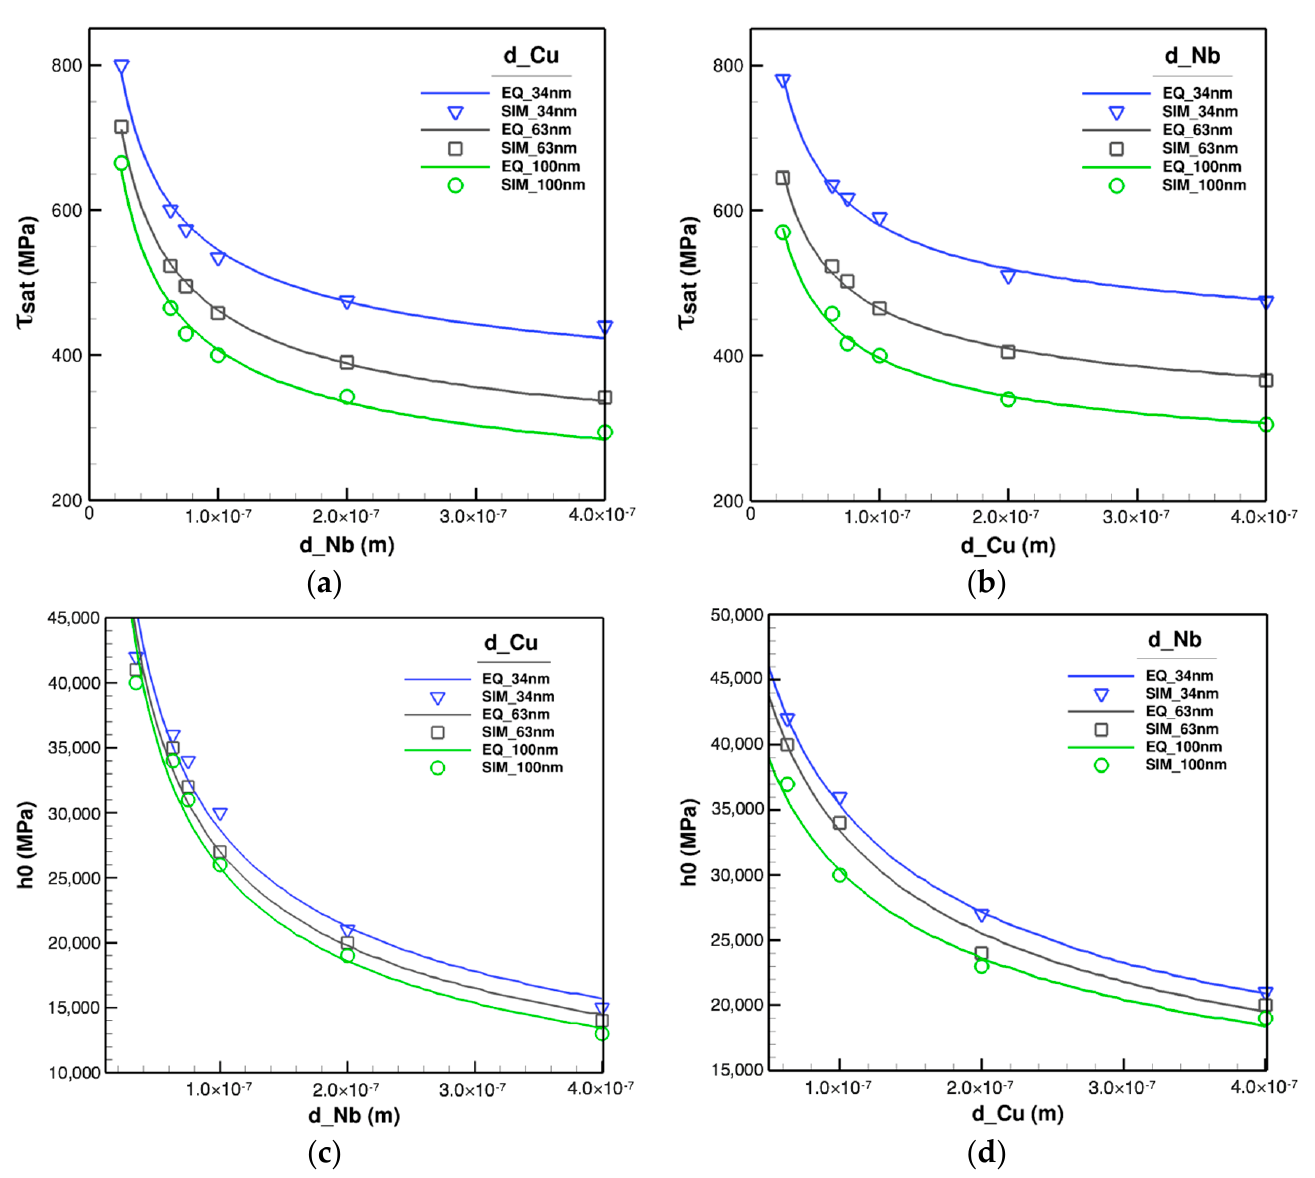
Figure 7. Variations of effective parameters in homogenized constitutive model with layer thicknesses where one layer thickness is fixed while the other one changes. Symbolic points signify simulation (SIM) results and solid lines the best fitted equivalent curves (EQ). Variations of τ sat , for ( a ) fixed Cu layer spacing, d_Cu, and ( b ) fixed Nb layer spacing, d_Nb. Variations of h 0 , for ( c ) fixed Cu layer spacing, d_Cu, and ( d ) fixed Nb layer spacing,